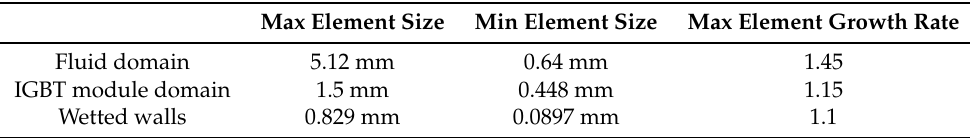
Table 4. Geometric values of mesh configurations.